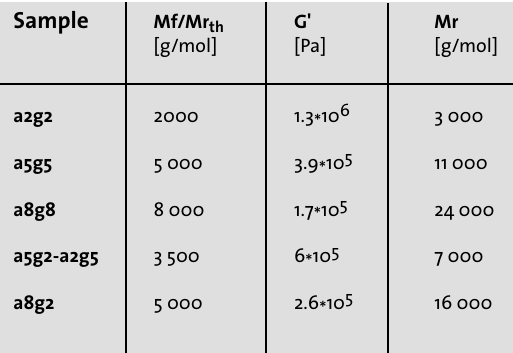
Table 2: Theoretical molar mass Mf between two func- tional units for symmetric blends, theoretical mass between two crosslinking units Mrth (Eq. 3); for sym- metric blends Mf= Mrth.